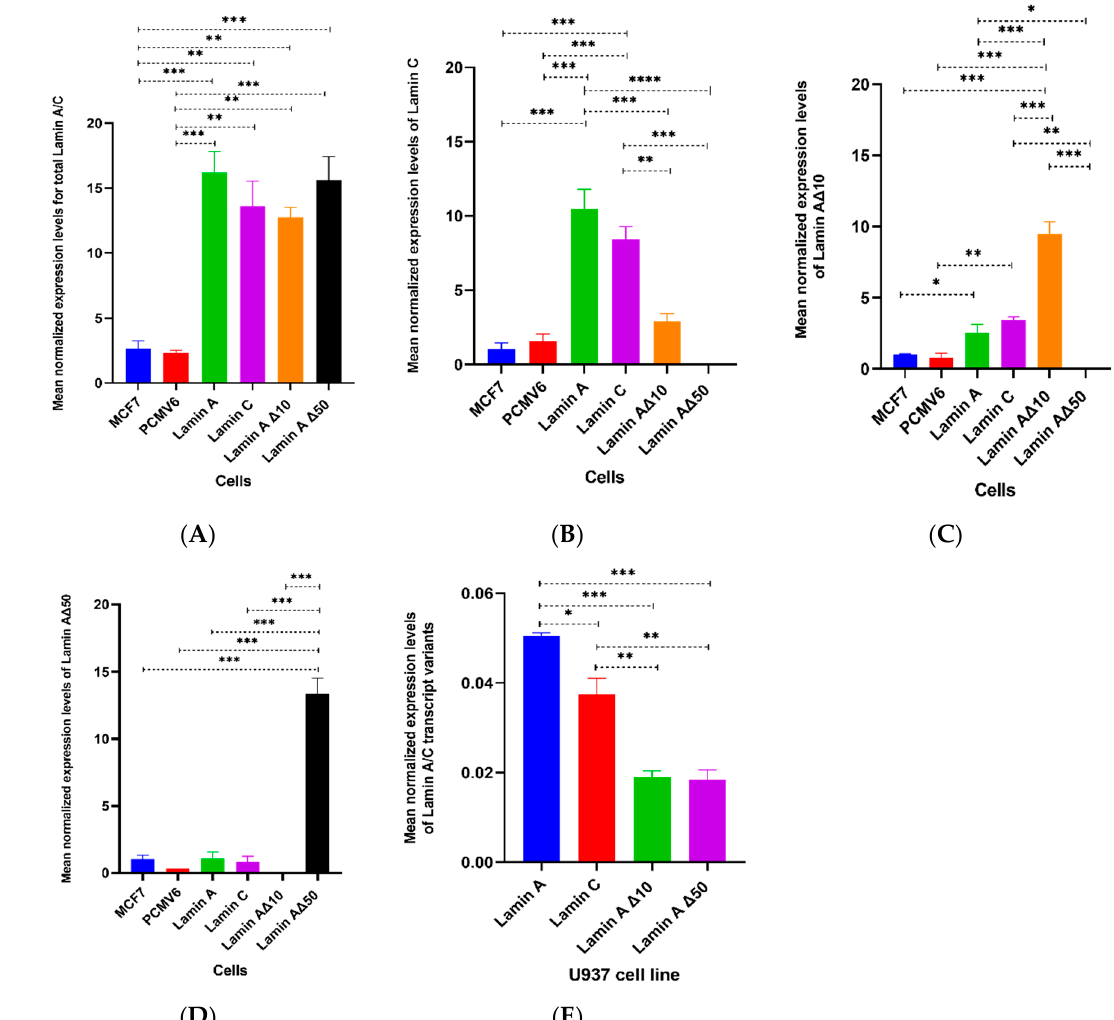
Figure 5. Differential mRNA expression levels of lamin A/C transcript variants: ( A ) Total lamin A/C , ( B ) lamin C , ( C ) lamin A Δ 10 , and ( D ) lamin A Δ 50 . mRNA expression levels were measured in native MCF7 and following transfection with PCMV6-XL4 plasmid (Mock transfection) or cDNA coding for lamin A, lamin C, lamin A Δ 10, or lamin A Δ 50 using RT-qPCR. Expression levels are expressed relative to non-transfected MCF7 expression levels. Differential mRNA expression levels of lamin A , lamin C , lamin A Δ 10 , lamin A Δ 50 were also measured in ( E ) the U937 cell line. Values are expressed as mean ± standard error ( n = 9). Statistical comparisons of significant differences between groups with adjoining lines: * p < 0.01, ** p < 0.001, *** p < 0.0001, **** p < 0.00001.